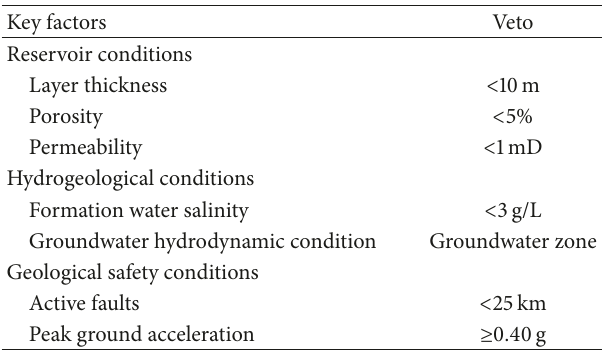
Table 8: Veto over key factors of CO 2 geological storage candidate prospective areas